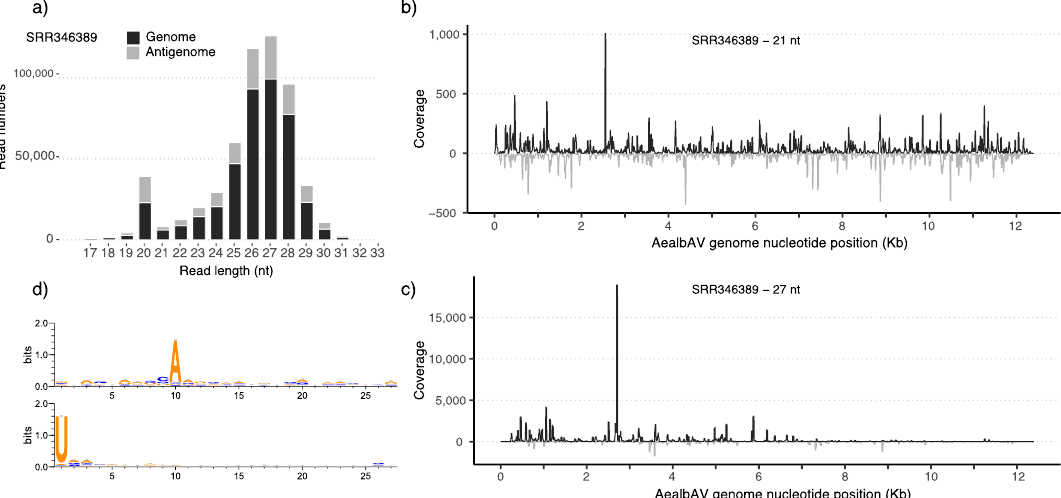
Figure 4. AealbAV-specific miRNAs in Ae. albopictus samples infected with CHIKV. ( a ) Size distribution of miRNAs mapping to the AealbAV genome (black) and antigenome (grey). ( b ) Mapping profiles of the 21-nt reads representing AealbAV-derived siRNAs and ( c ) the 27-nt reads representing AealbAV-derived piRNAs. ( d ) Relative nucleotide frequency and conservation of the 27-nt vpiRNAs that mapped to the genome (upper panel) and the antigenome (bottom panel) of AealbAV. AealbAV-derived vpiRNAs display the characteristic piRNA ping-pong signature with Adenine at position 10 for the genomic strand and Uridine at position 1 for the antigenomic